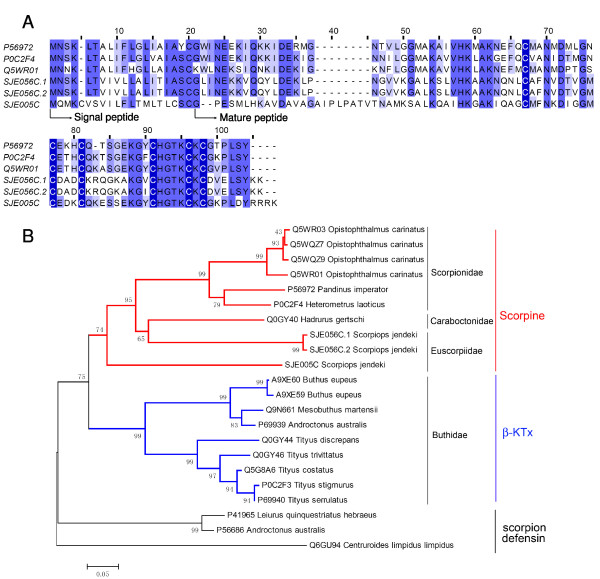
Scorpines. (A) Sequence alignment of scorpines. SJEs are clusters from this work. The others are P56972 (Scorpine, Pandinus imperator), P0C2F4 (Heteroscorpine-1, Heterometrus laoticus), and Q5WR01 (Opiscorpine-2, Opistophthalmus carinatus). (B) Phylogeny analysis of β-KTxs and scorpines from scorpion venoms. To minimize confusions, all proteins from previous work are represented by their SWISS-PROT accession numbers. Scorpion defensins are used to root the phylogeny tree.